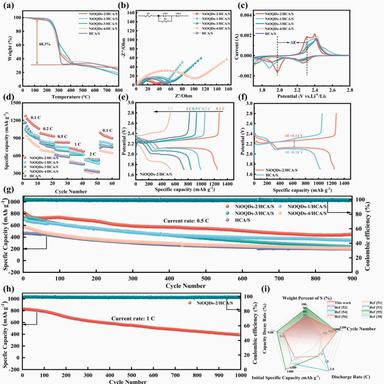
(a) thermogravimetric analysis (TGA) curve; (b) EIS spectra before cycling; (c) CV curves of five samples at 0.1 mV s − 1 ; (d and e) rate capability and chargedischarge curves; (f) voltage difference at same rate; (g, h) cyclic performance and coulombic efficiency at 0.5 C and 1 C; (i) Comparison of the electrochemical performance of this work with other materials reported in the literature.